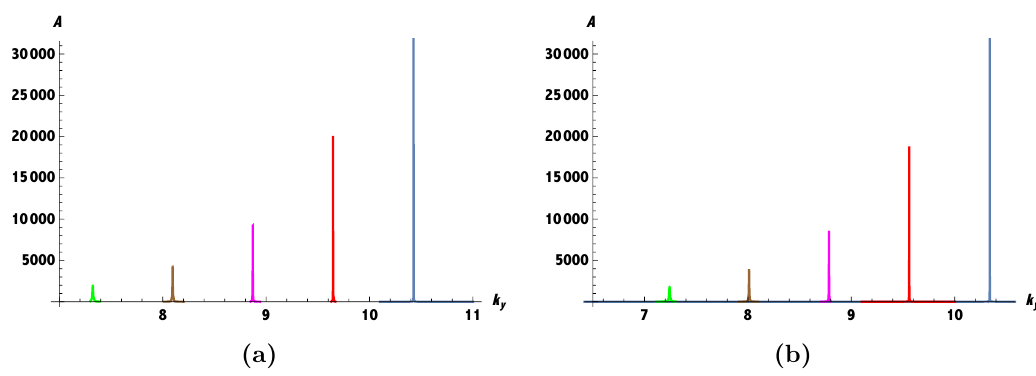
Figure 1. Plot of spectral function A vs. k y with k x = 0 . The peak shifts from right to left with decreasing charges. We have plotted for q =9 (blue), 8.5 (red), 8 (magenta), 7.5 (brown), 7 (green). (a) a i = 0 (b) a i =0.2. The height of the plot for q = 9 is truncated so as to get all the peaks visible in the